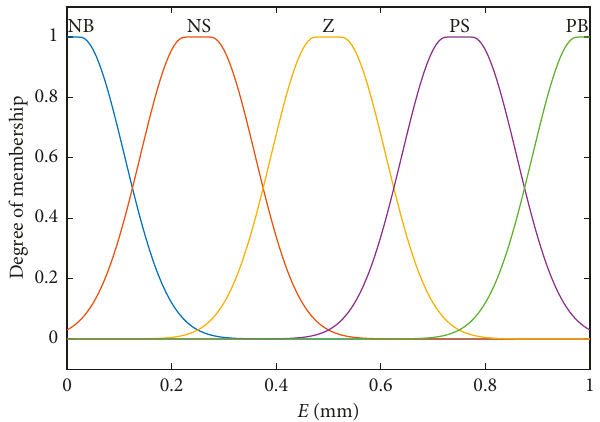
Figure 6: Gaussian membership